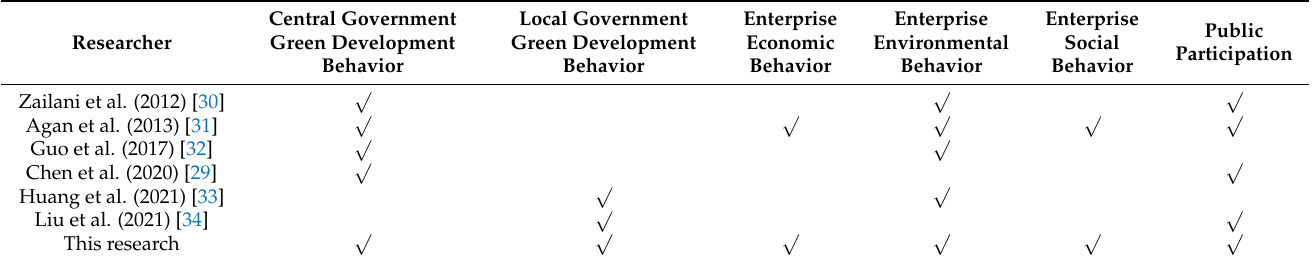
Figure 2. Integration theory model. Table 1. Research